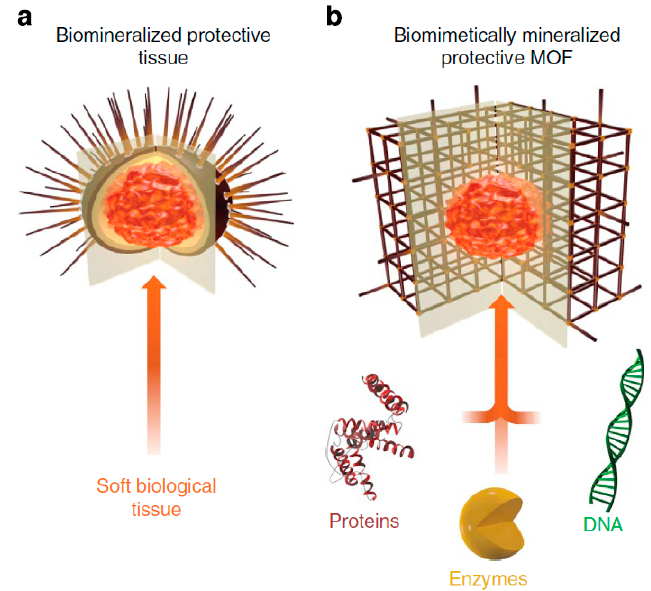
Figure 10. Schematic illustration of biomimetically mineralized metal–organic framework (MOF). ( a ) Schematic of a sea urchin, a hard, porous, protective shell that is biomineralized by soft biological tissue. ( b ) Schematic of an MOF biocomposite showing a biomacromolecule (for example, protein, enzyme, or DNA) encapsulated within a porous, crystalline shell. (Reprinted from [108], license CC BY